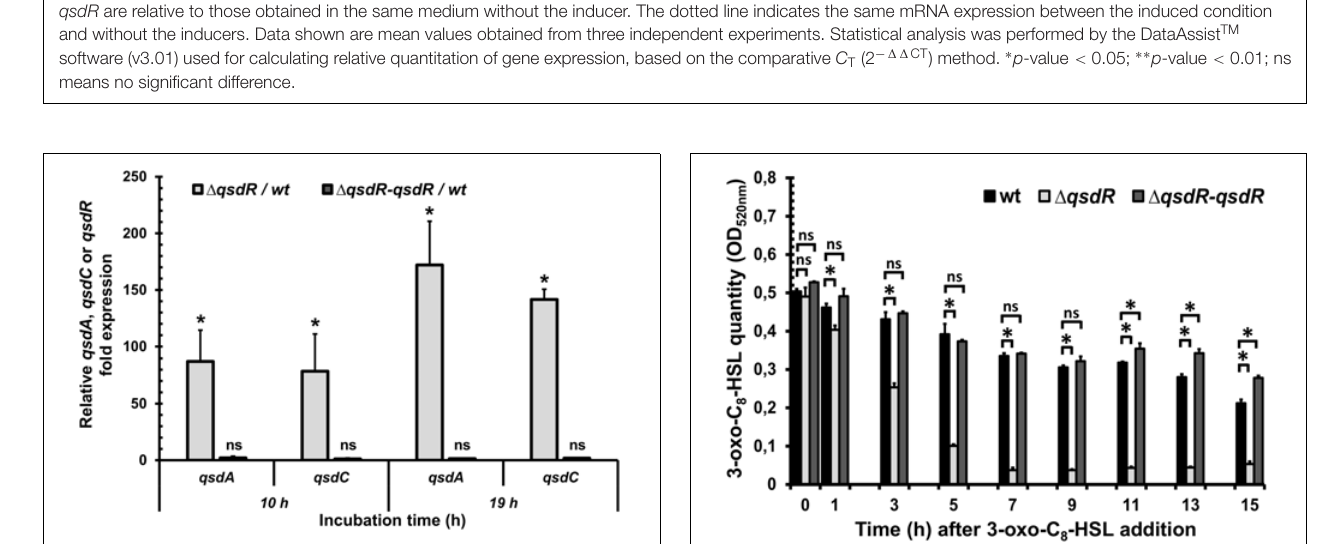
FIGURE 4 | Degradation kinetics of 3-oxo-C 8 -HSL by the R. erythropolis R138 wild-type, (cid:49) qsdR or the complementing strains. Dosage was performed by a colorimetric method in the culture supernatant after centrifugation. Data are the mean ± standard deviation of three independent experiments. Statistical analyses were performed using non-parametric Mann–Whitney tests (two tailed). For each incubation time, ∗ indicates a significant difference in the 3-oxo-C 8 -HSL quantity in the presence of the (cid:49) qsdR mutant or the complementing strains ( p -value < 0.05) relative to that observed in the presence of the wild-type strain. ns mean no significant